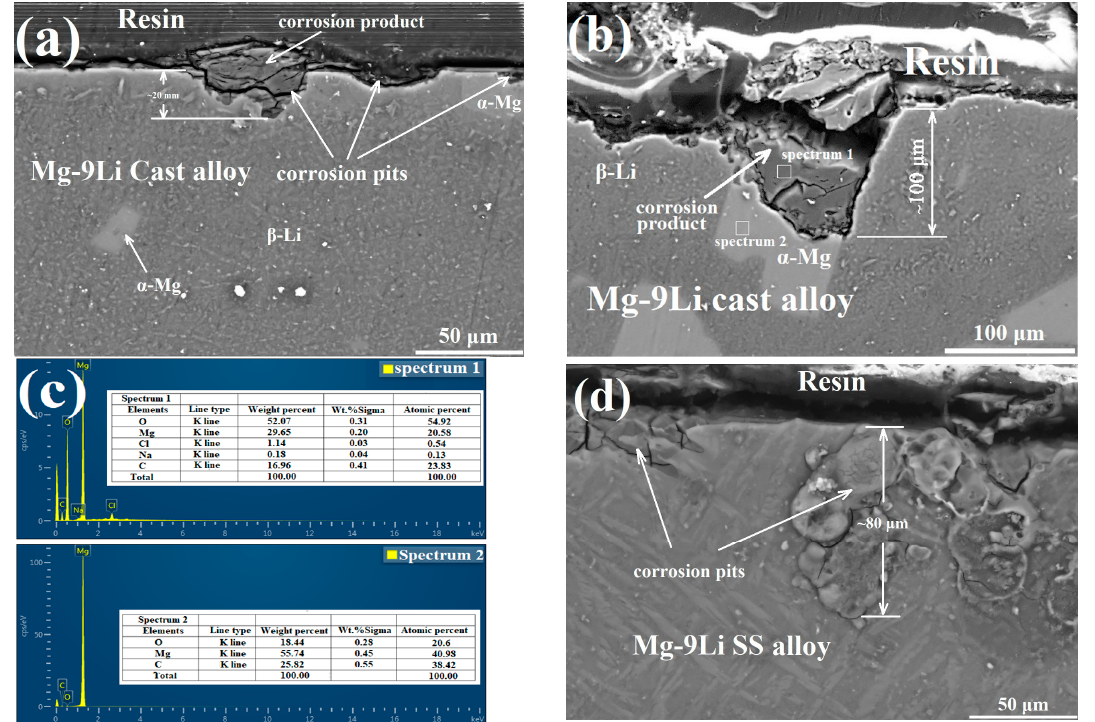
Figure 10. SEM cross-sectional view corrosion morphologies of the alloys obtained in different exposure time. ( a ) and ( b ) are the cast alloy obtained after 4-h and 5-days exposure, respectively; ( c ) EDS analysis of the cast alloy; and ( d ) SS alloy after 5-days exposure.